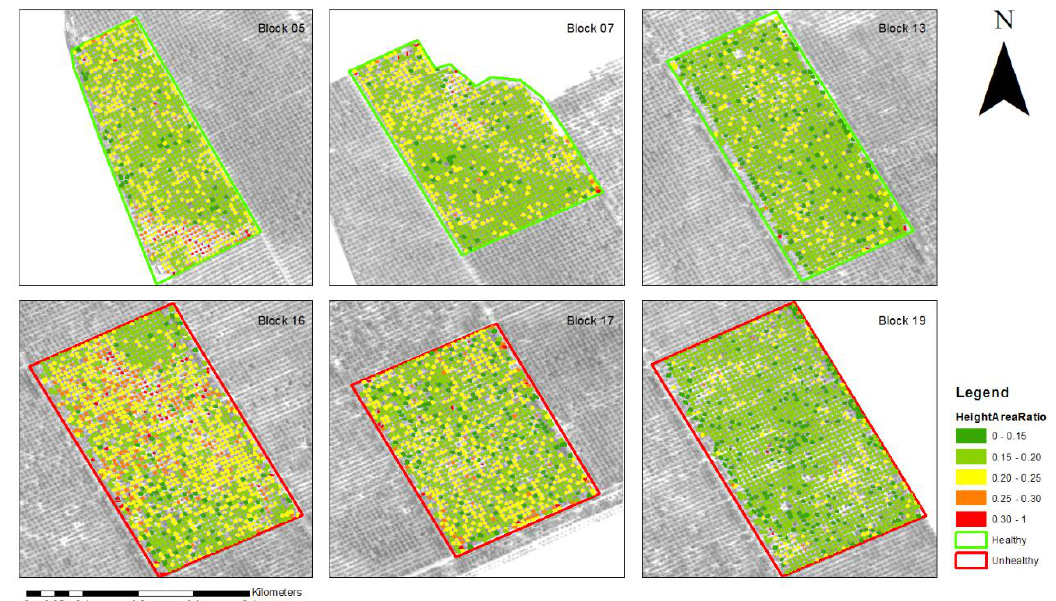
Figure 8. The height area ratios of the derived tree polygons representing individual trees for the test blocks.